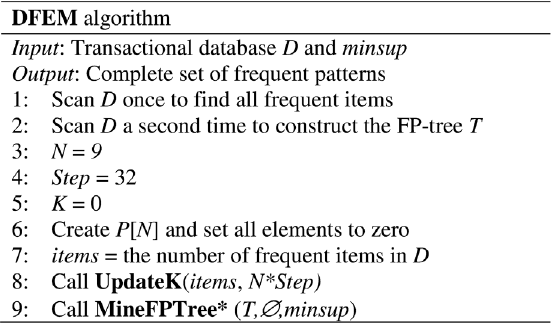
Figure 10. DFEM Algorithm.